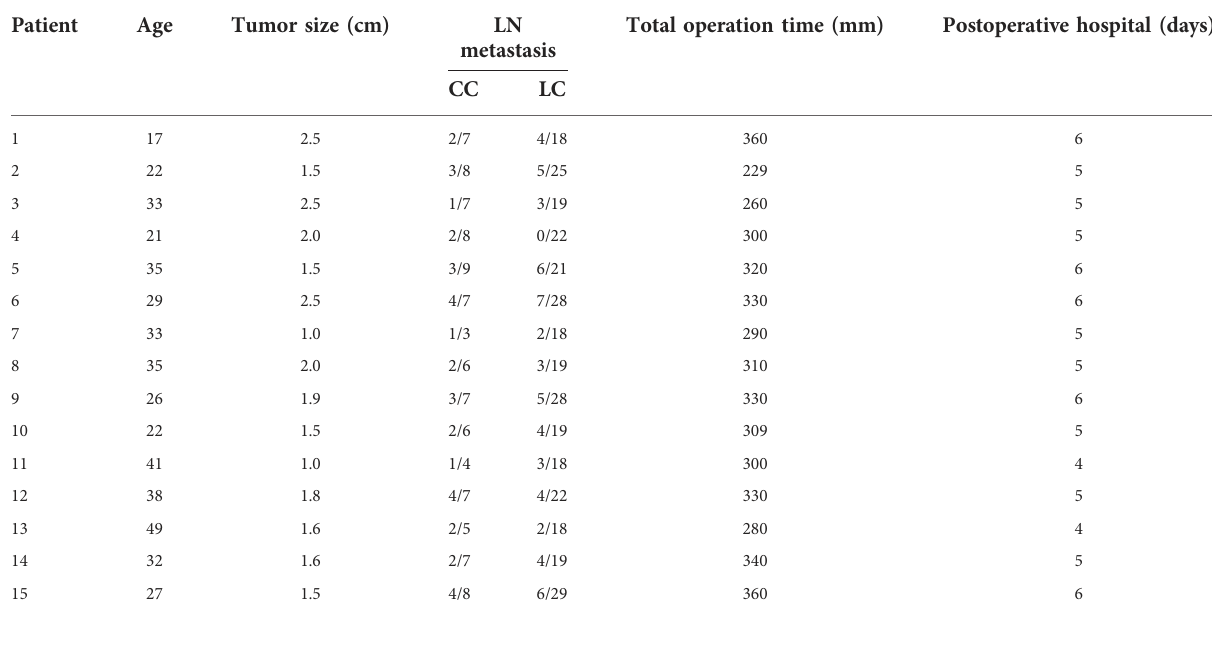
TABLE 1 Clinical characteristics of including patients of this